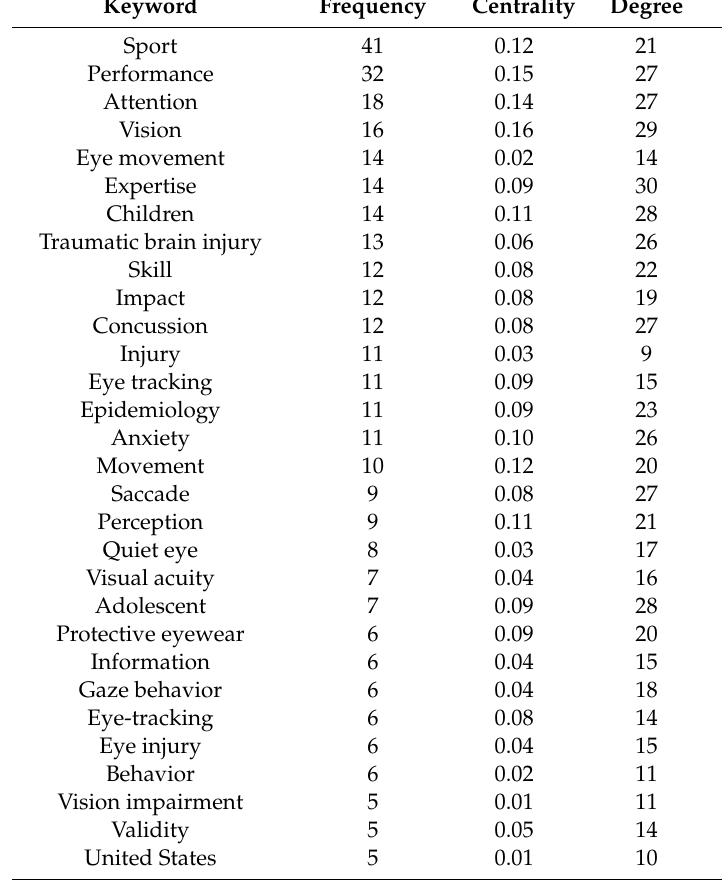
Table 6. The most used